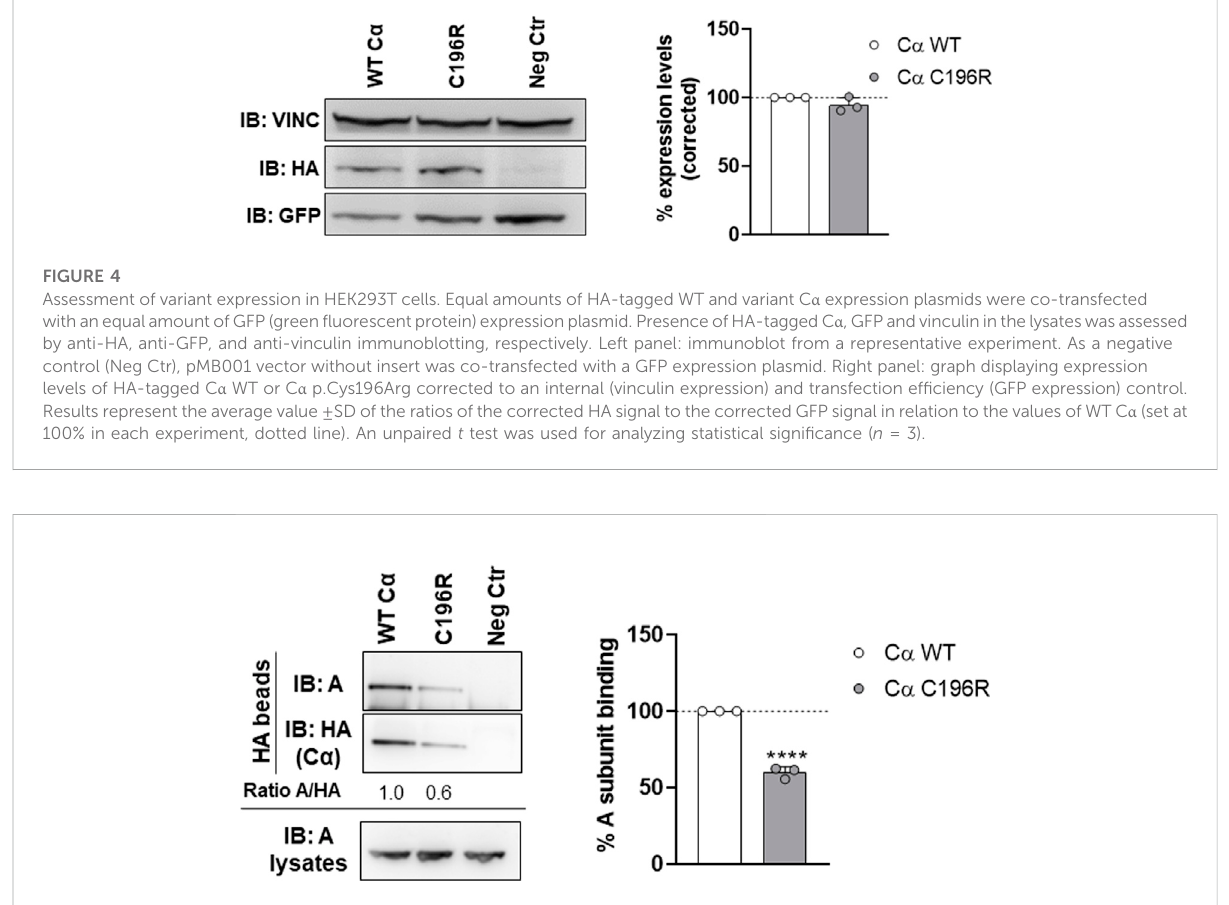
FIGURE 5 Binding of PP2A C α p.Cys196Arg to the structural A subunit. HA-tagged C α WT and p.Cys196Arg proteins were puri fi ed from transfected HEK293T cells by HA-pulldown. Presence of endogenous A subunit in the complexes was measured by anti-HA immunoblotting. Left panel: immunoblotfromarepresentativeexperiment.Asanegativecontrol(NegCtr)pMB001vectorwithoutinsert(expressingonlyHAtag)wasused.Right panel: graph displaying quanti fi ed values of A subunit binding. Results represent the average value ±SD of the ratios of the quanti fi ed anti-A signal to the quanti fi ed anti-HA signal in relation to those values of C α WT (set at 100% in each experiment, dotted line). An unpaired t test was used for analyzing statistical signi fi cance ( n = 3; ****, p ≤ 0.0001).